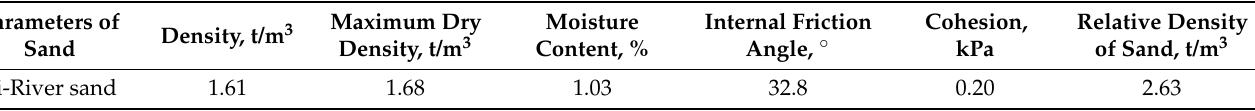
Table 2. Physical and mechanical parameters of the Li-River